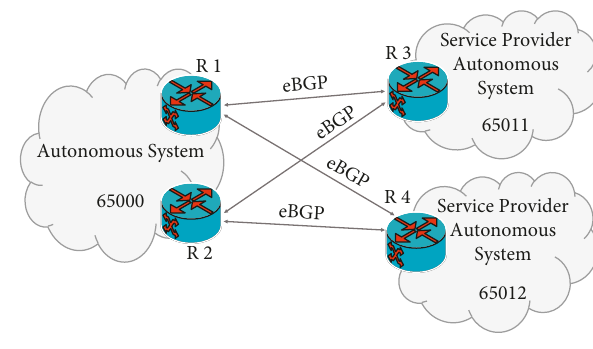
Figure 9: Dual multihomed AS [69].